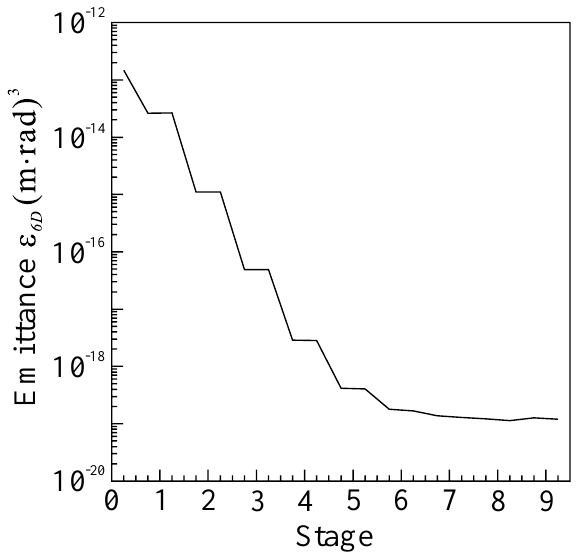
FIG. 6. The 6D emittance of the electron beams.